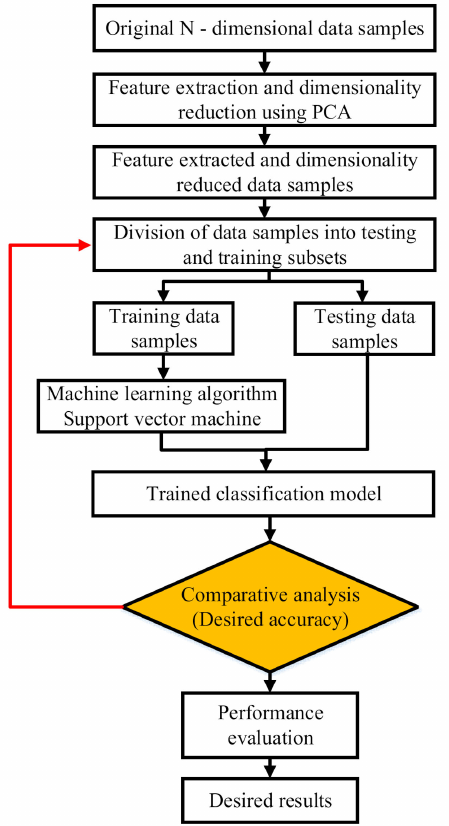
Figure 3. Proposed flow chart of SVM based